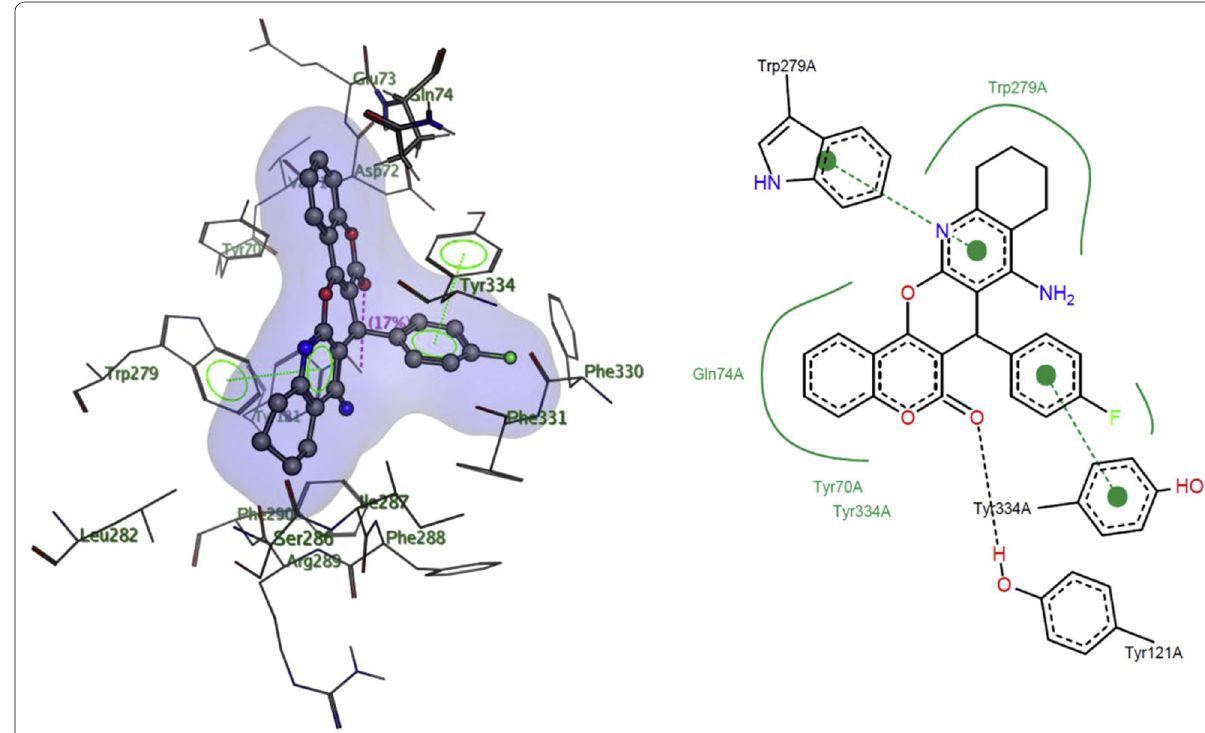
Fig. 17 Residues involved in the interactions with C11 and the 2D representation of binding mode of C11 in the gorge of AChE